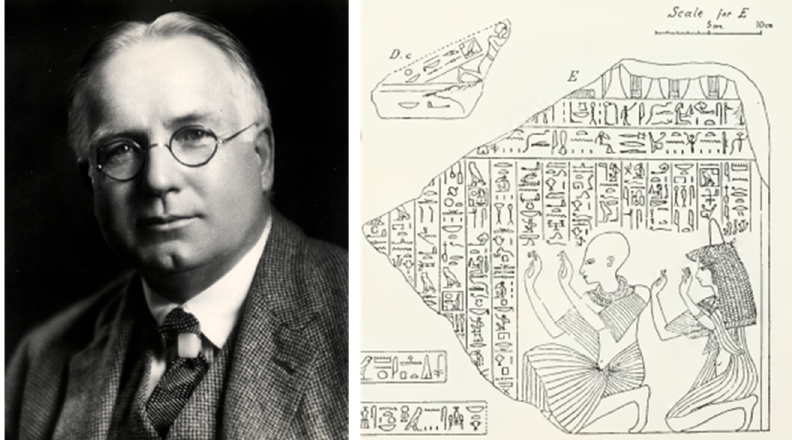
Figure 1. Charles T. Currelly, first Director of the Royal Ontario Museum; Attribution: University of Toronto Archives, 2004-30-7MS, public domain. Line drawing made by Currelly during excavation of the tomb of King Nebhepetre, also known as Mentuhotep II, (Dynasty XI) in Deir el-Bahri, Egypt in 1906 [2], Plate VIII, public domain.